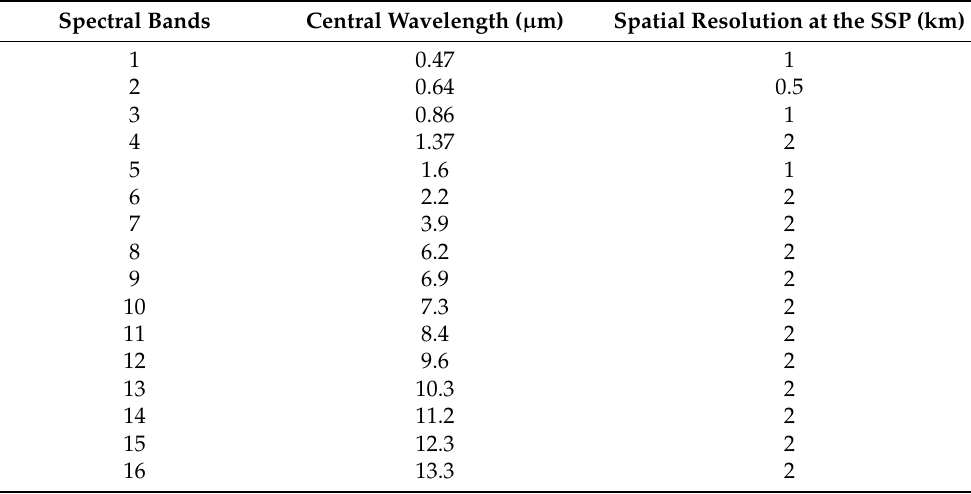
Table 2. Main features of the ABI instrument aboard GOES-R